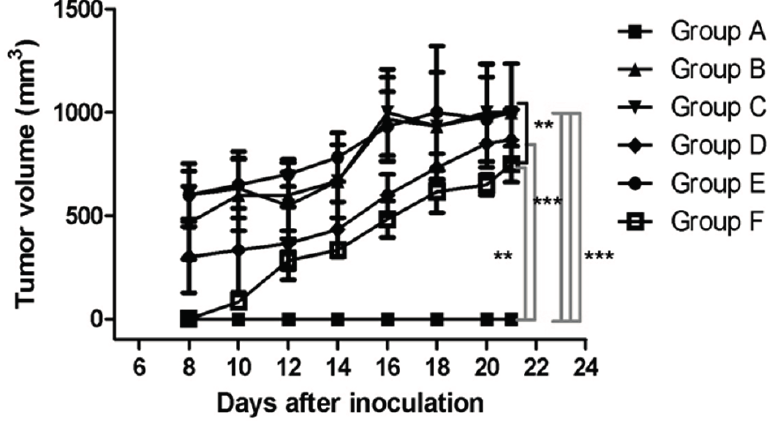
Figure 3. Tumor volumes (mm 3 ) in the different experimental groups on day 21 of the experiment. ** p < 0.01, *** p <